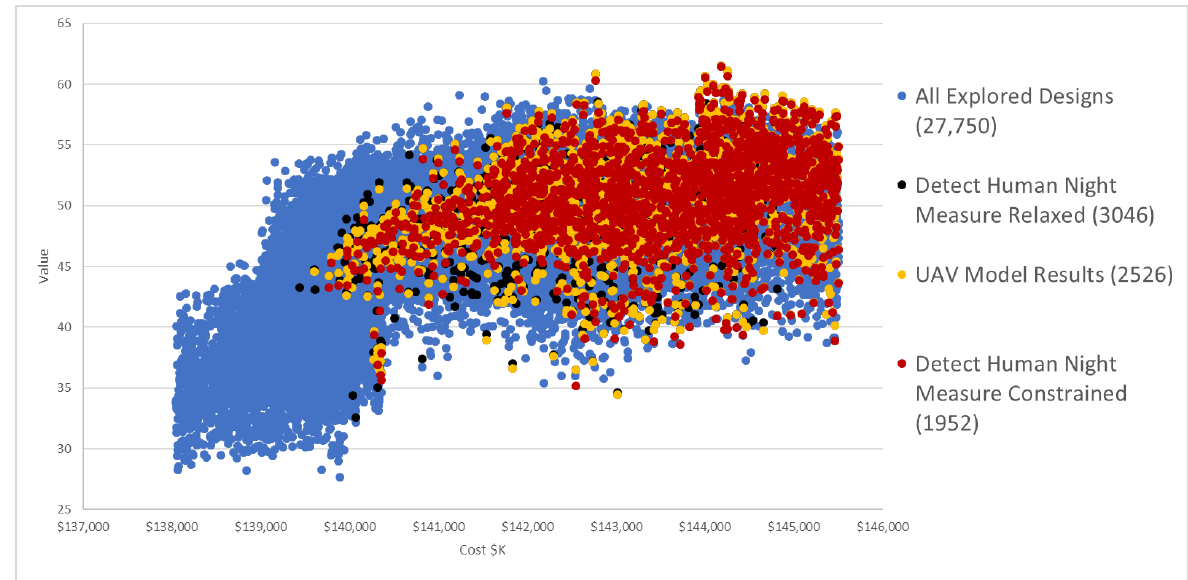
Figure 10. Effect on Feasible Tradepsace by Changing Most Sensitive UAV Requirement.